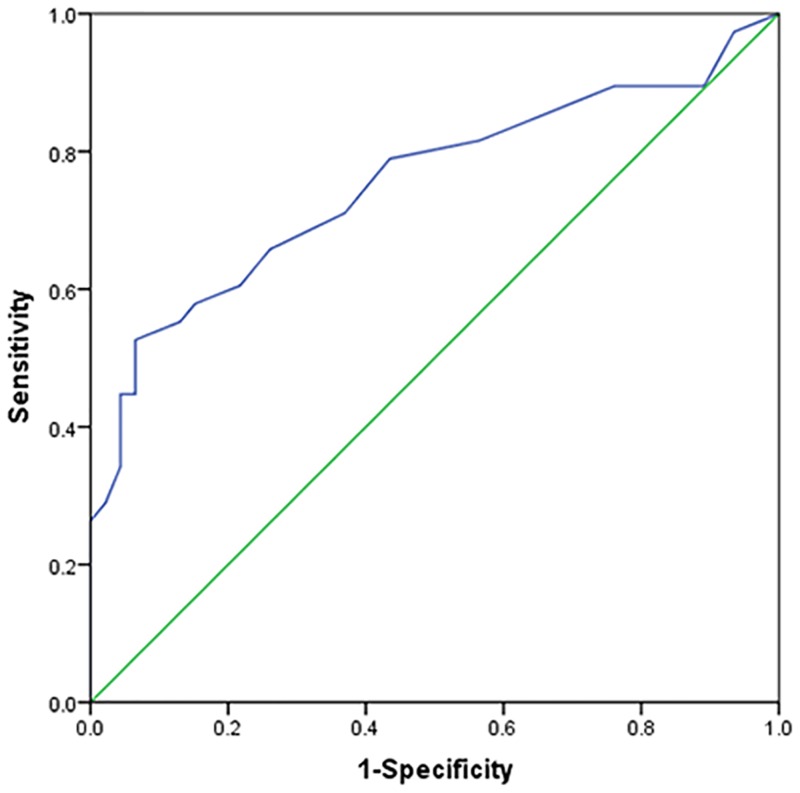
The receiver operating curve (ROC) analysis of pretreatment plasma D-dimer levels.The optimal cut-off value for D-dimer levels to predict mortality is 1.2μg/mL (sensitivity = 52.6%, specificity = 93.5%, accuracy = 75.0%).